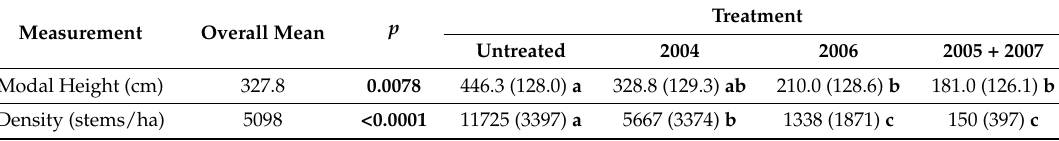
Table 7. Effects of treatments on aspen modal height and density in 2014. Standard deviation is shown in brackets () beside each mean. Where Analysis of Variance indicates significant treatment effects ( p < 0.10), p values are shown in bold and bold letters are used to indicate differences between treatments determined using Tukey’s HSD test ( p < 0.10).